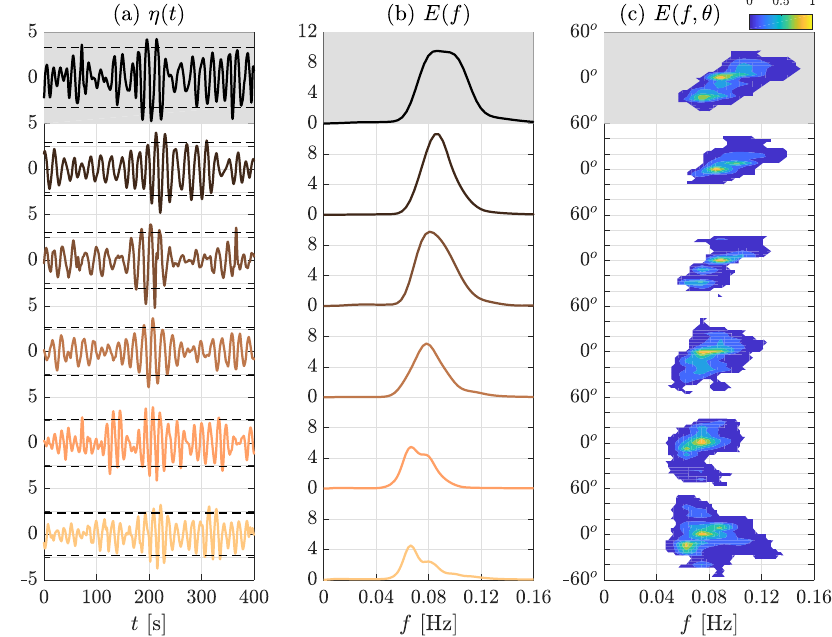
b , c Thehorizontalaxisdenotesfrequency,in b theverticalaxiswaveenergyandin c direction. Two-dimensional spectra are shown in Cartesian coordinates as the spectracoveronlyanarrowdirectionalrange, − 60 ∘ < θ <60 ∘ ,andnormalisedbythe peak energy to highlight directional properties (colorbar shown next to the title). a – c Shaded backgrounds denote the measurement location in intermediate ice